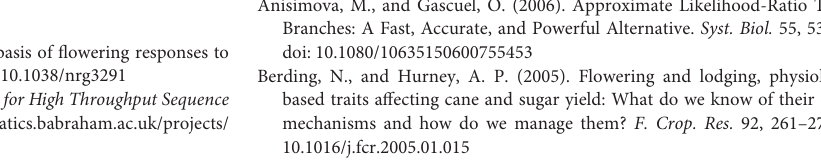
Supplementary Table 6 | List of conserved sugarcane lncRNAs responsive to flowering induction and its orthologs in S. bicolor , Z. mays , and S. italica (sorted by highest to lowest log 2 fold